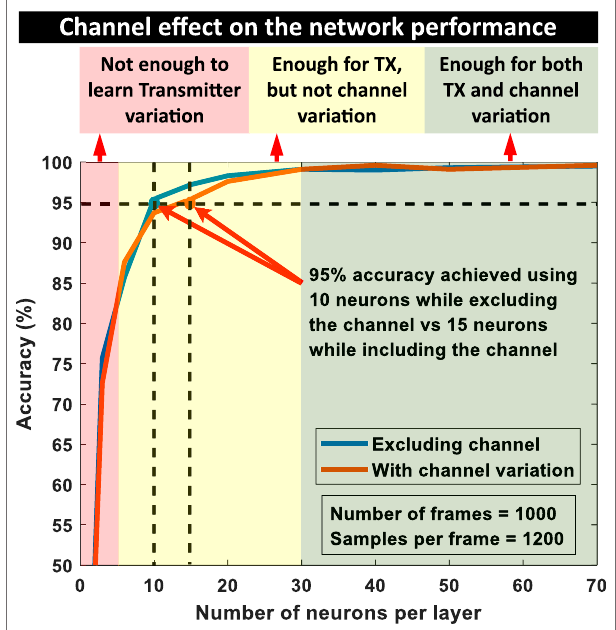
FIGURE 7 | Comparison of the network performance in the cases of including and excluding the wireless channel data. The network needs 15 neurons compared to 10 neurons in a hidden layer to achieve 95 % accuracy for the case where the channel is considered. But with higher model capacity, both lines converge and the network learns the channel effect on data. d thenetworklearns thechannel effect on data.The light red box shows theregionwherethenetworkfailstolearntransmittervariation,lightyellowbox shows the region where the network learns transmitter variation but fails to learn the variation due to the wireless channel. The light green box shows the region where the network learns both the transmitter and channel variation